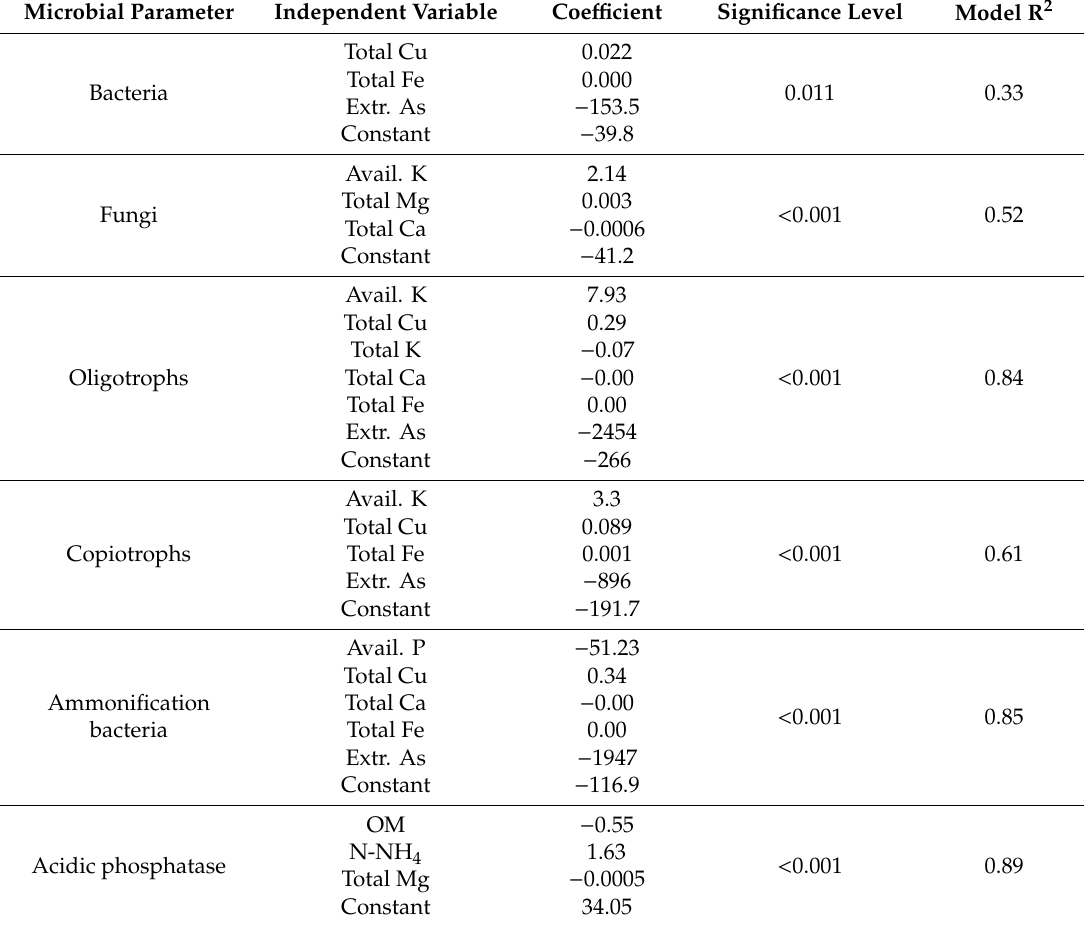
Table 6. Stepwise regression model fitting results for microbial abundance and enzyme activities in FW and SW soils ( n =